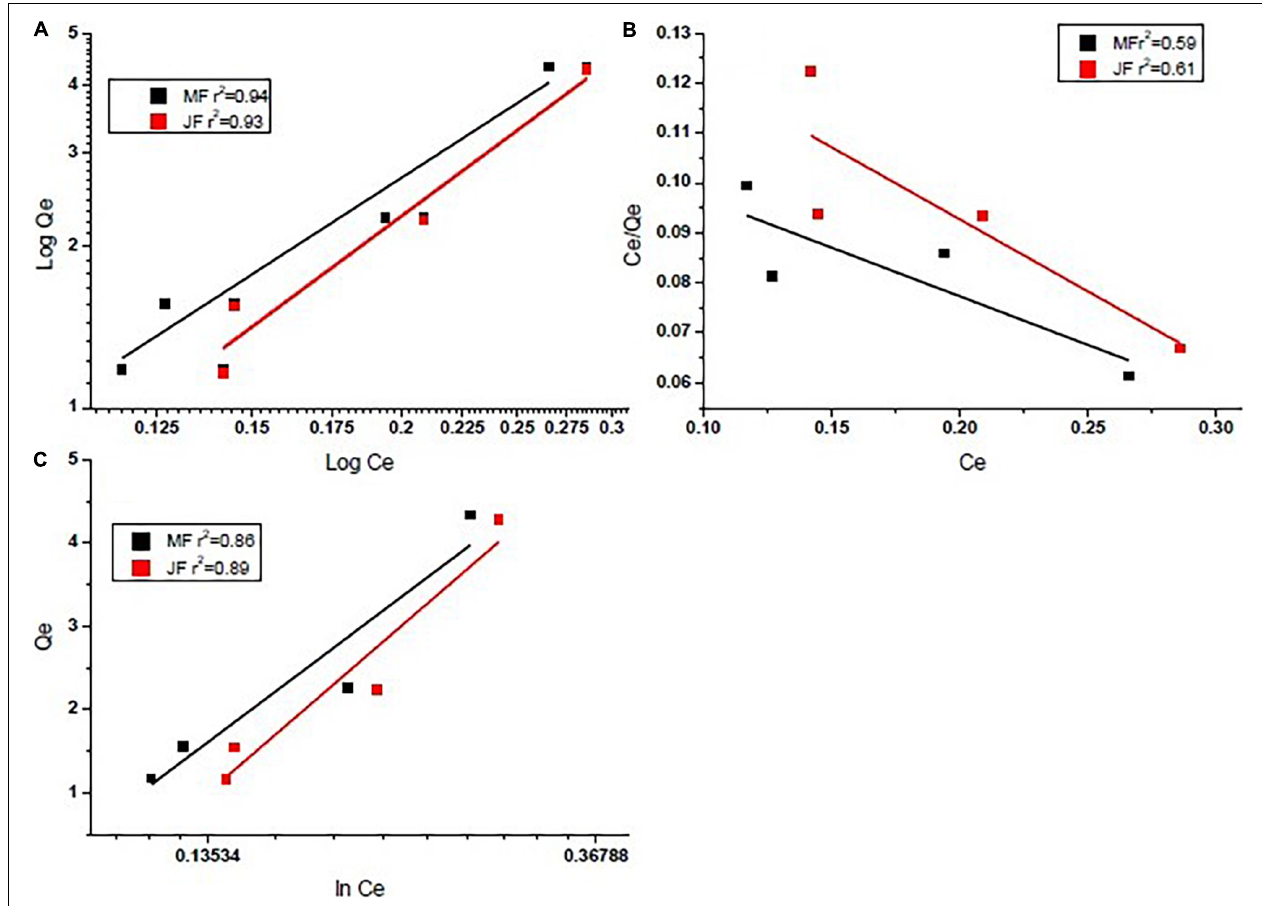
FIGURE 5 | Equilibrium isotherms of chromium by using seed bio-sorbent of Mango (M) and Jackfruit (JF): (A) Freundlich model, (B) Langmuir model, and (C) Tempkin model.